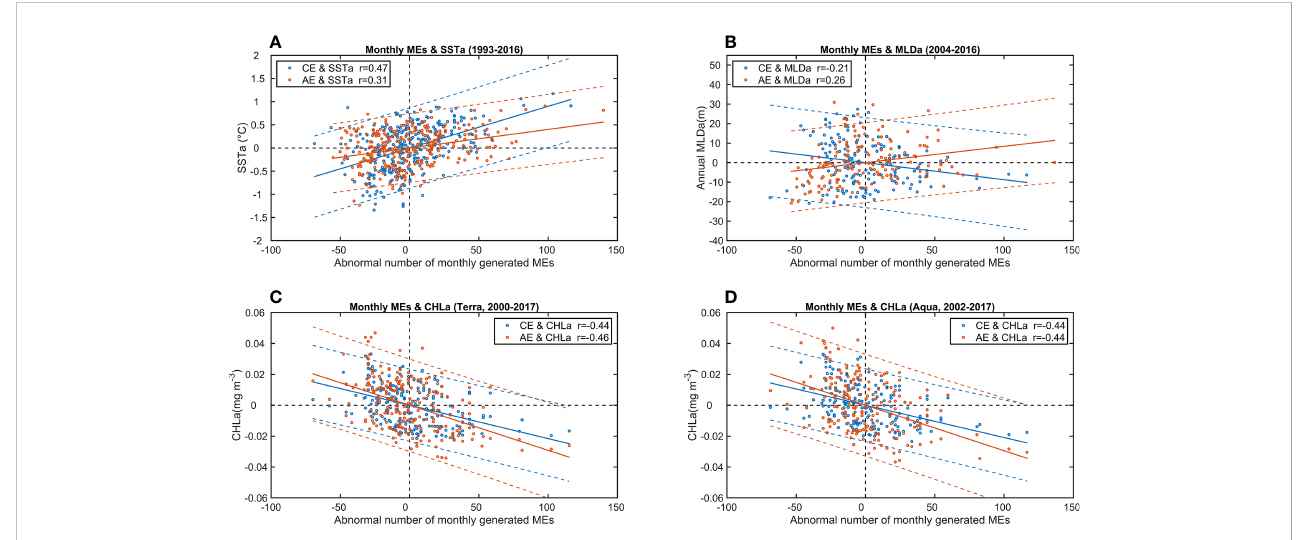
FIGURE 10 Linear regression fi tting between abnormal number of monthly generated MEs (CEs and AEs) number and monthly (A) SSTa, (B) MLD anomalies (MLDa), (C) CHL anomalies (CHLa, Terra), and (D) CHLa (Aqua). The correlation coef fi cients are labeled in the sub fi